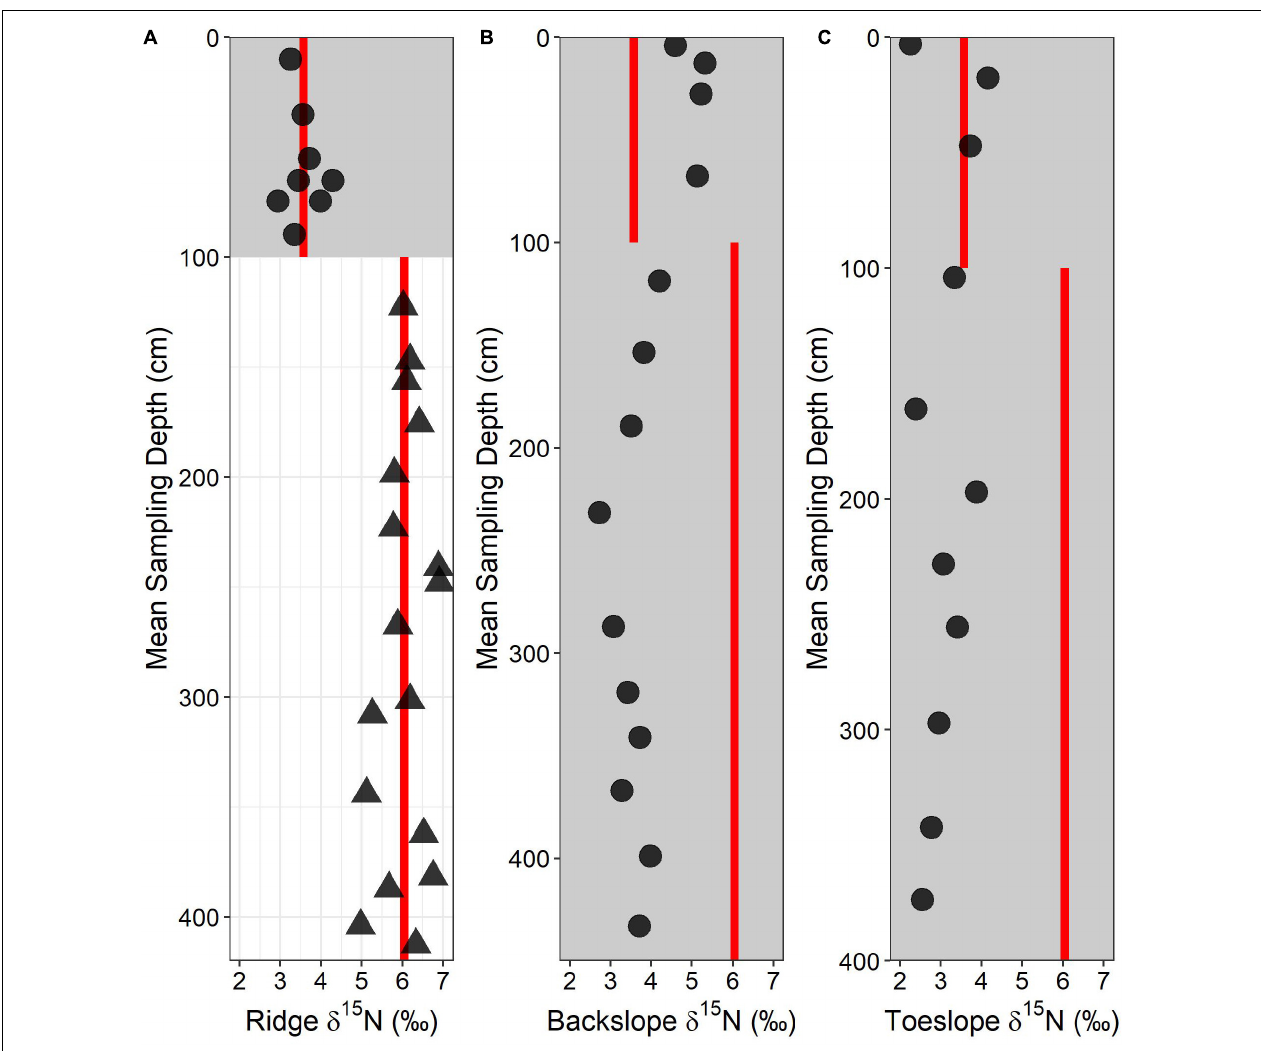
FIGURE 8 | Total soil-d 15 N depth profile for (A) ridge, (B) backslope, and (C) toeslope soils. Circles and gray shaded area represent soil samples whereas triangles and no shading represent saprolite and bedrock samples. Red lines indicate mean values of the soil and saprolite/rock d 15 N values from the ridgecrest